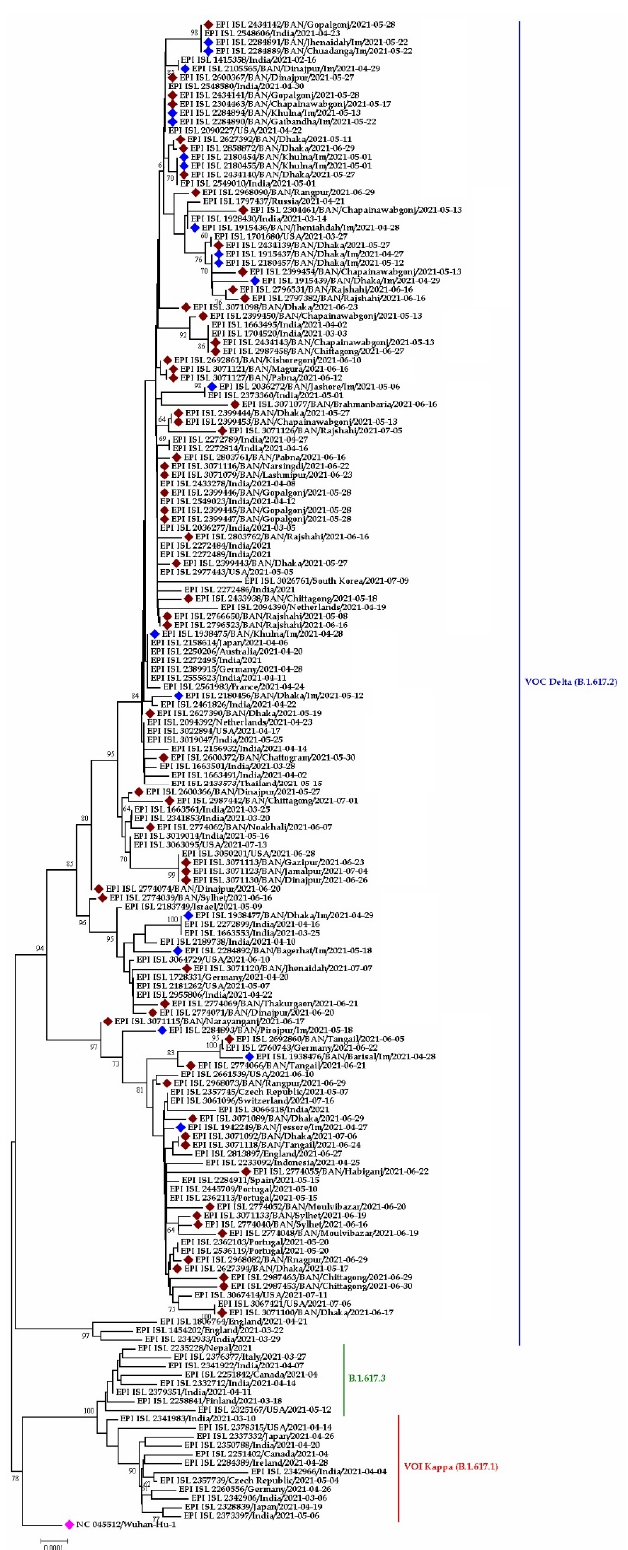
Figure 10. Phylogenetic analysis of sub-lineage of Delta variant (B.1.617.2) in Bangladesh. Here, maroon dots denote community transmission of Delta variant SARS-CoV-2 viruses; blue and pink dotes denote imported SARS-CoV-2 Delta variant and Wuhan-Hu-1 viruses, respectively. B.1.617.3 and B.1.617.1 were used as out group